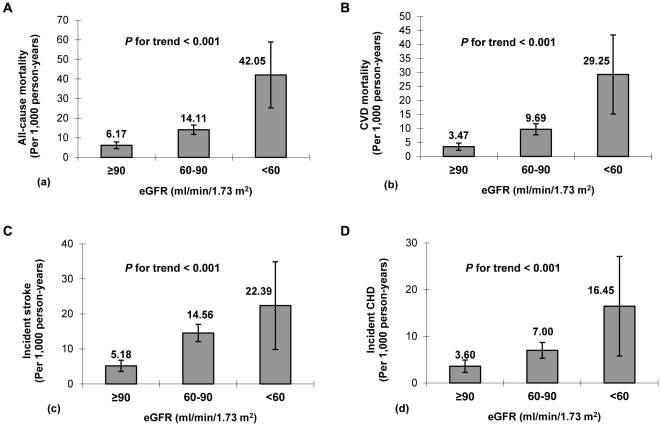
The rates and 95% confidence intervals of all-cause mortality (a), CVD mortality (b), stroke (c), and CHD (d) in patients with hypertension according to eGFR categories.CVD, cardiovascular disease; CHD, coronary heart disease, eGFR, estimated glomerular filtration rate.